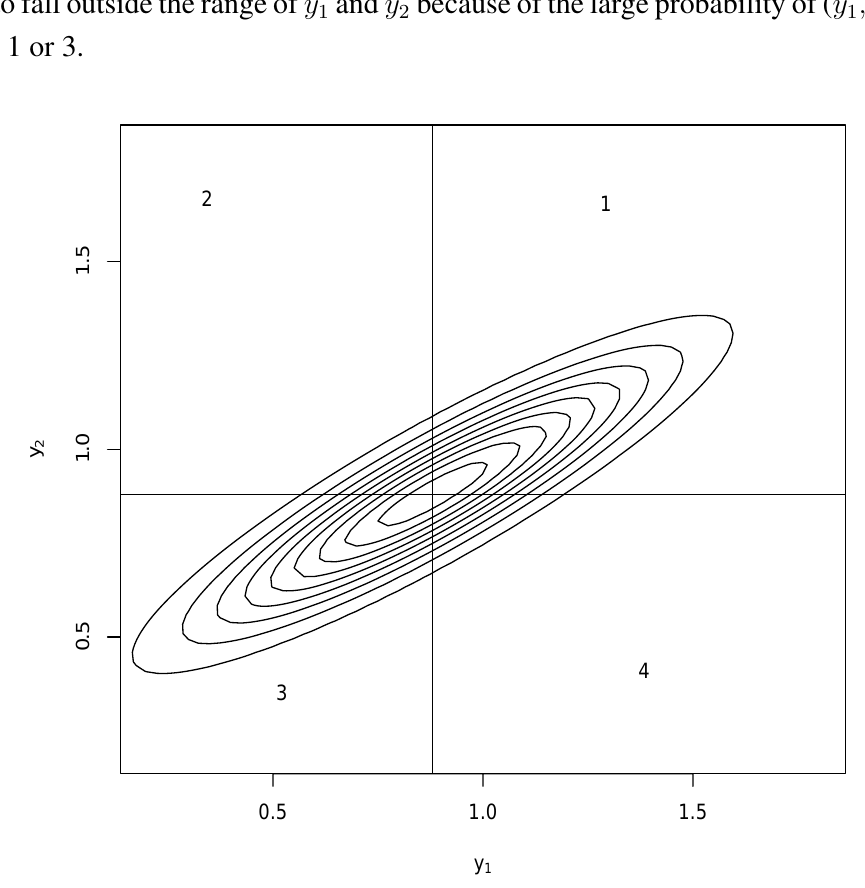
and y because of the large probability of ( y 1 2